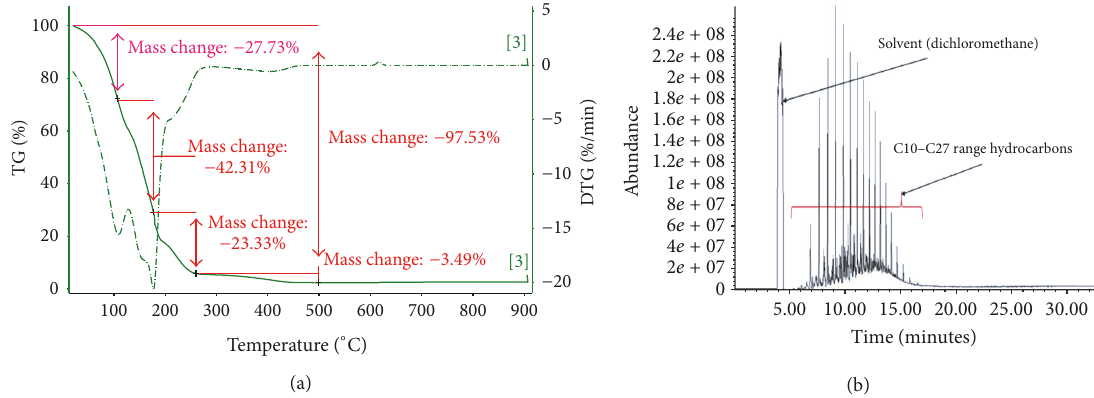
Figure 5: (a) The thermal gravimetric analysis and (b) gas chromatography mass spectrometry